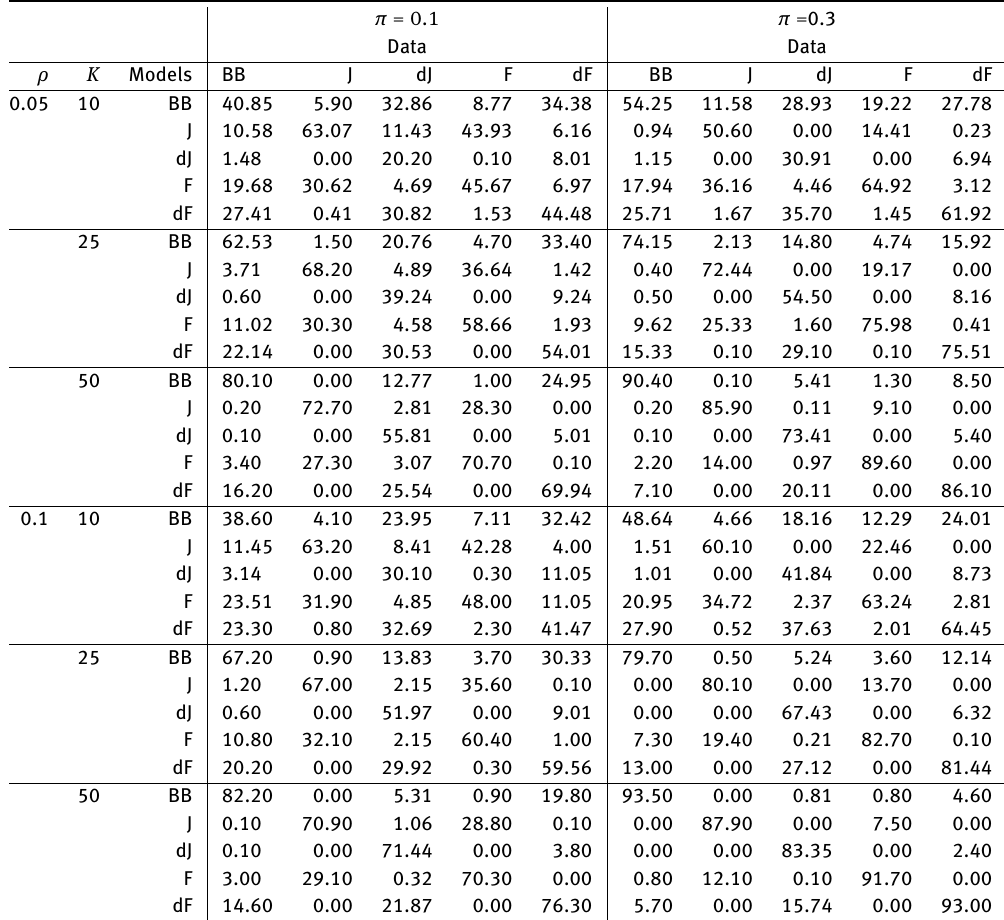
Table 4: Large cluster simulations: The proportion of times that a model is selected by the AIC criterion as a function of the model used to simulate the data. π = 0.1 π =